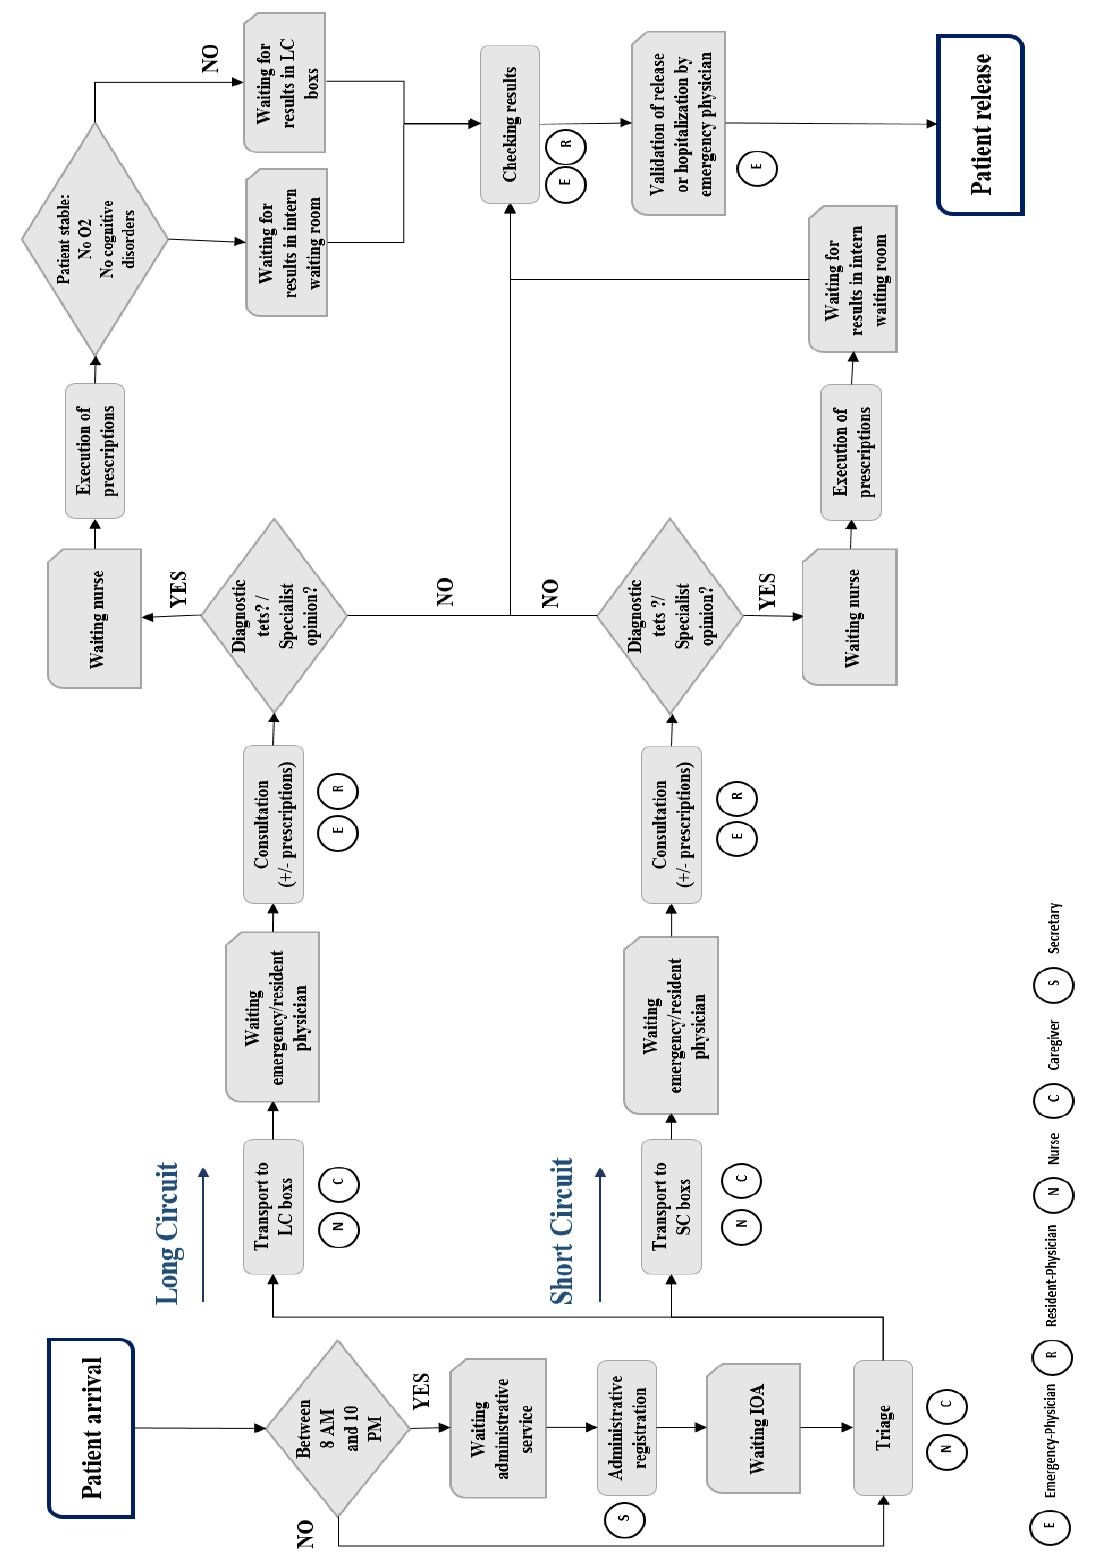
Figure 2. Diagram of patient flow in ED